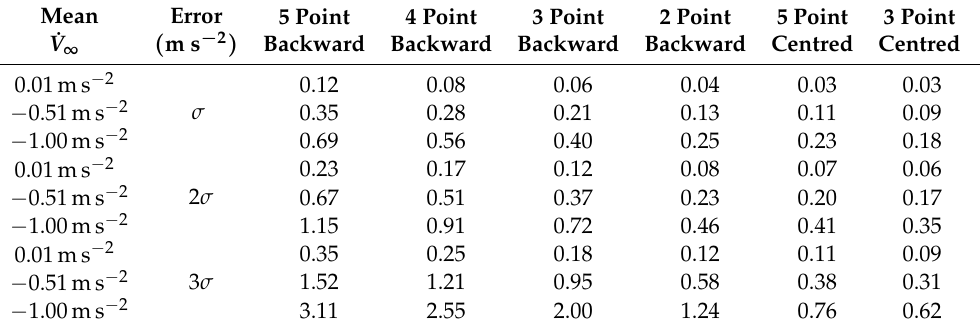
Numerical error analysis using different numerical schemes for airspeed time derivative calculation. With 1 σ , 2 σ and 3 σ is intended the value such that the